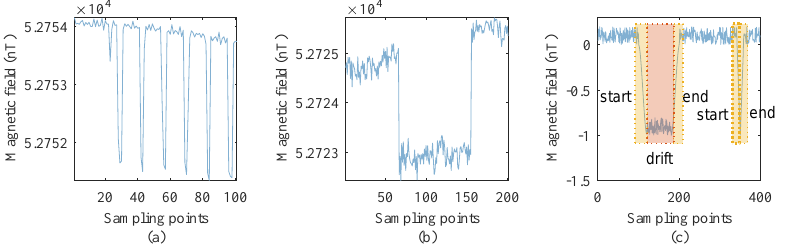
Figure 1. Typical OBE generated by the software interferences: ( a ) the short-term interference, ( b ) the long-term interference, and ( c ) the description of